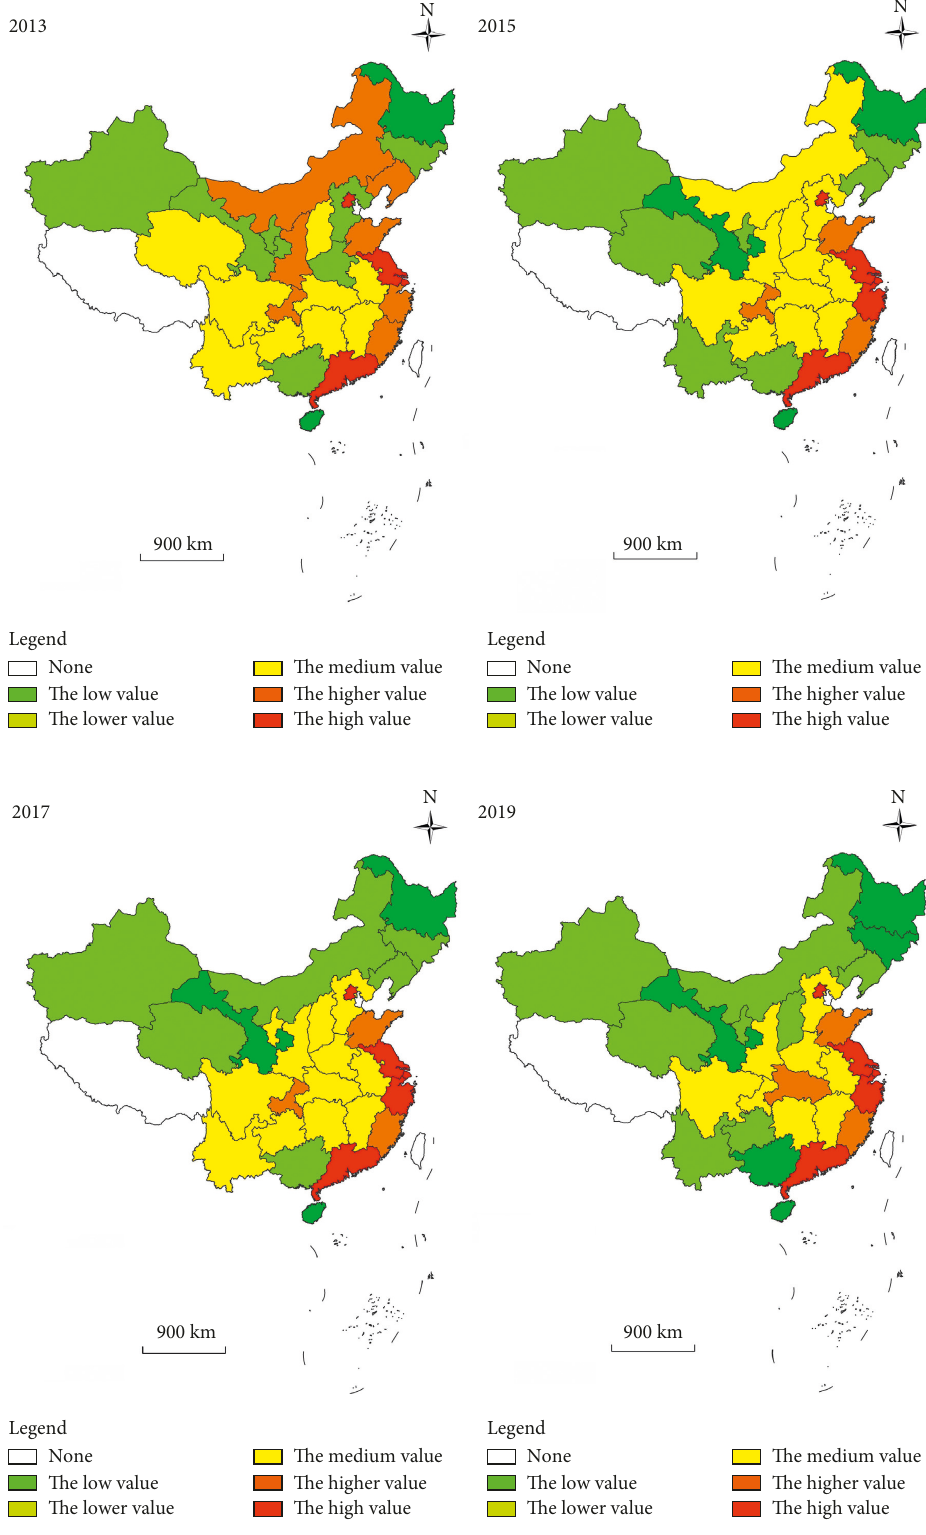
Figure 1: 2013–2019 provincial regional economy development